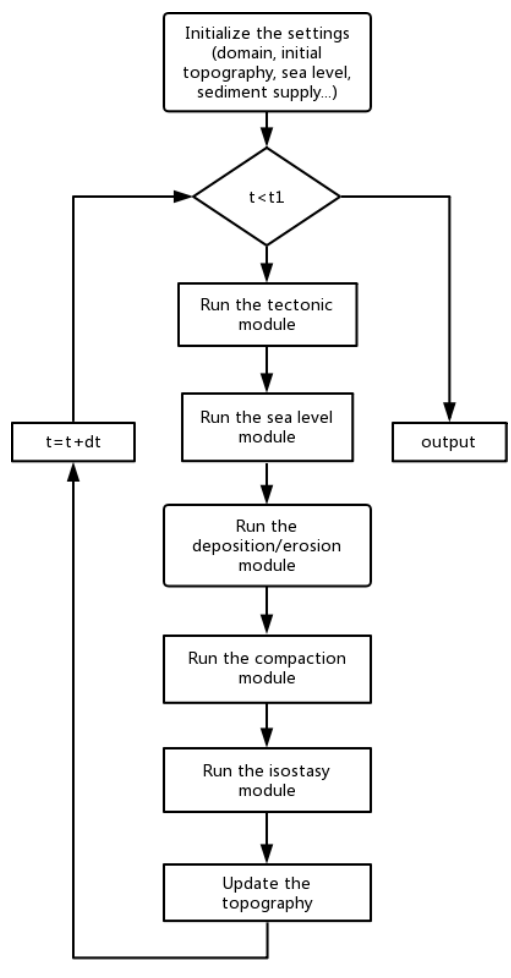
Figure 1. Flowchart of the algorithms in